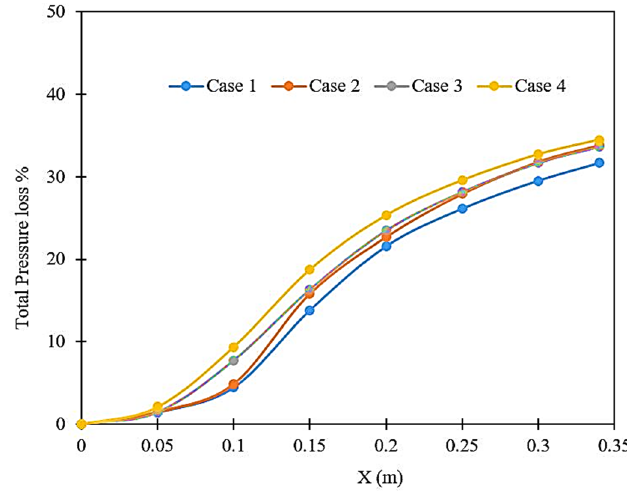
Figure 13. Total pressure loss across the various locations of the combustor.